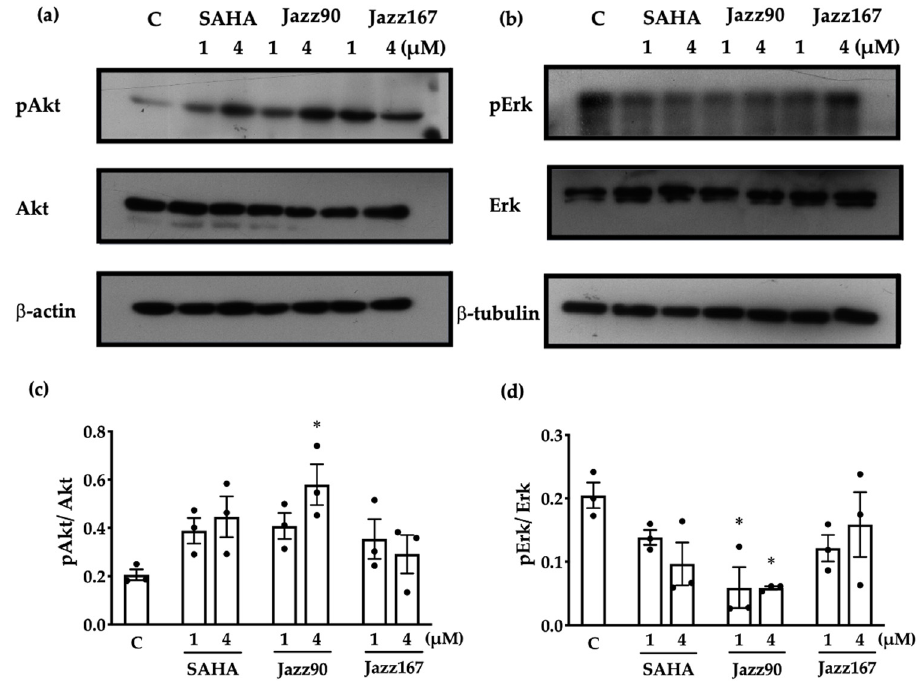
Figure 3. Compound-mediated changes in pAkt/Akt and pErk/Erk in PC3 cells. PC3 cells were treated with SAHA, Jazz90 and Jazz167 at 1 and 4 µM. Vehicle control cells (C) were treated with 0.5% DMSO. Cells were harvested 24 h after treatment. Representative Western blots for ( a ) pAkt, Akt and β -actin (loading control) and ( b ) pErk, Erk and β -tubulin (loading control). Densitometry of scanned Western blots for ( c ) pAkt and ( d ) pErk is shown. Bars represent the mean ± S.E.M. from 3 independent experiments, as shown by the data points. Data were analysed using a two-way ANOVA followed by a Bonferroni’s post-hoc test. *significantly different relative to the control, p < 0.05.